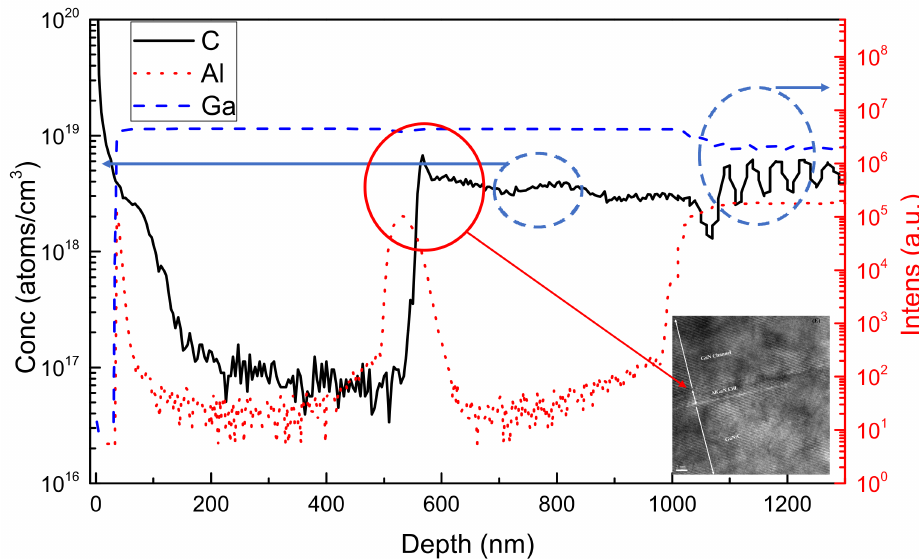
Figure 2. SIMS depth profiles of C, Ga, Al for the AlGaN/GaN HEMT with GaN:C and AlGaN EBL buffer, the insert shows AlGaN EBL between GaN:C and UID GaN